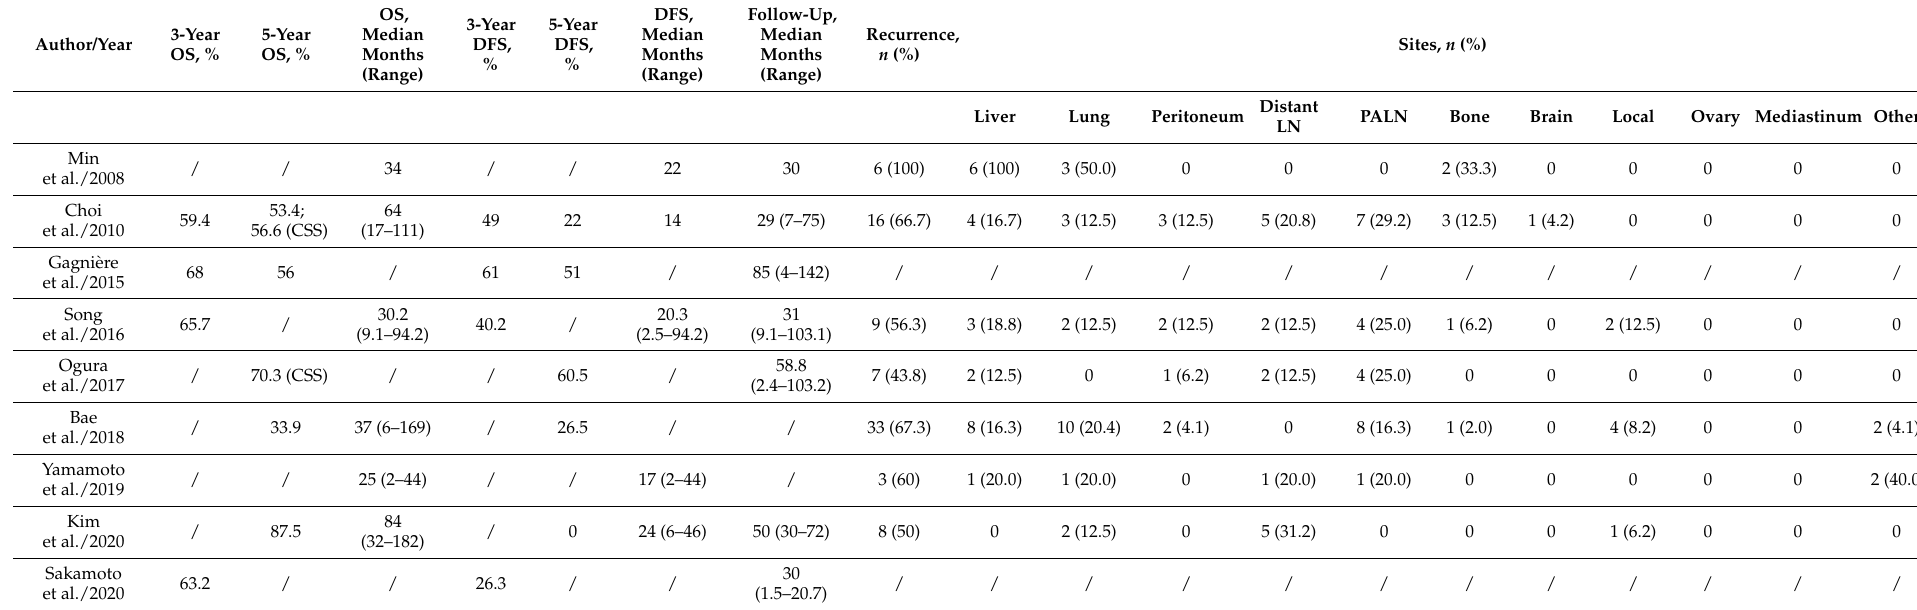
Table 4. Long-term outcomes and